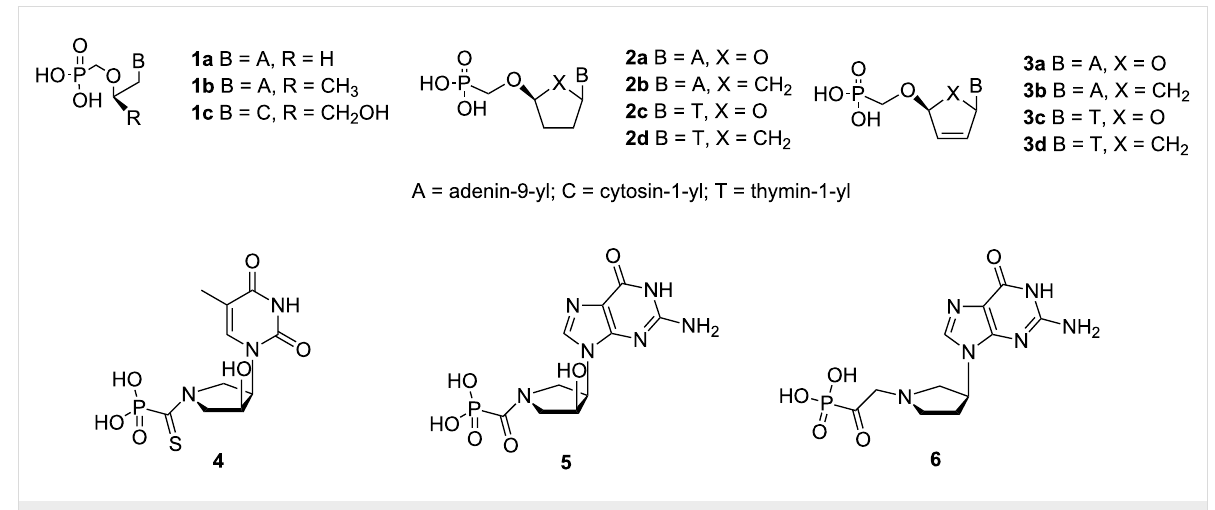
Figure 1: Examples of biologically active acyclic and cyclic nucleotide analogs.